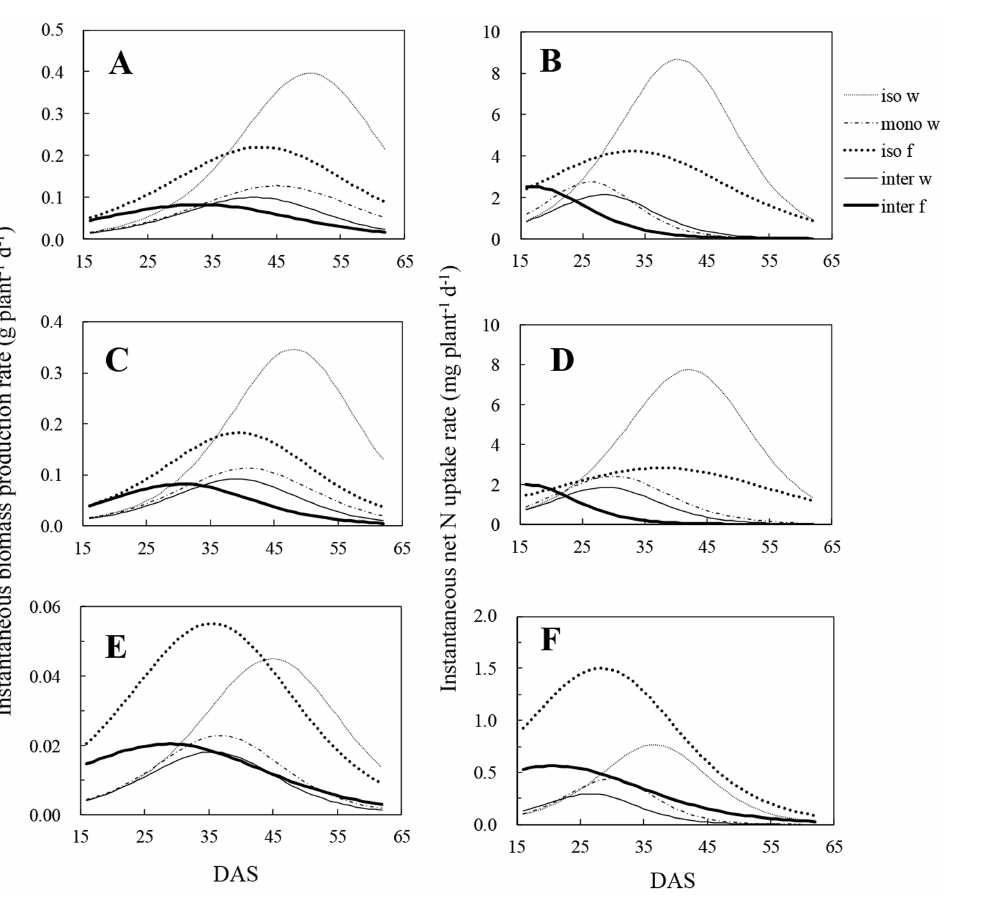
Fig. 4. Instantaneous rate of biomass production (A, C, E), and instantaneous rate of nitrogen (N) uptake (B, D, F). A, B: total rate of biomass production and N uptake by wheat and faba bean of different planting systems. C, D: shoot growth rate and instantaneous per capita N uptake by shoot of wheat and faba bean. E, F: root growth rate and instantaneous per capita N uptake by root of wheat and faba bean. iso w: isolated wheat; mono w: monocropped wheat; iso f: isolated faba bean; inter w: intercropped wheat; inter f: intercropped faba bean.